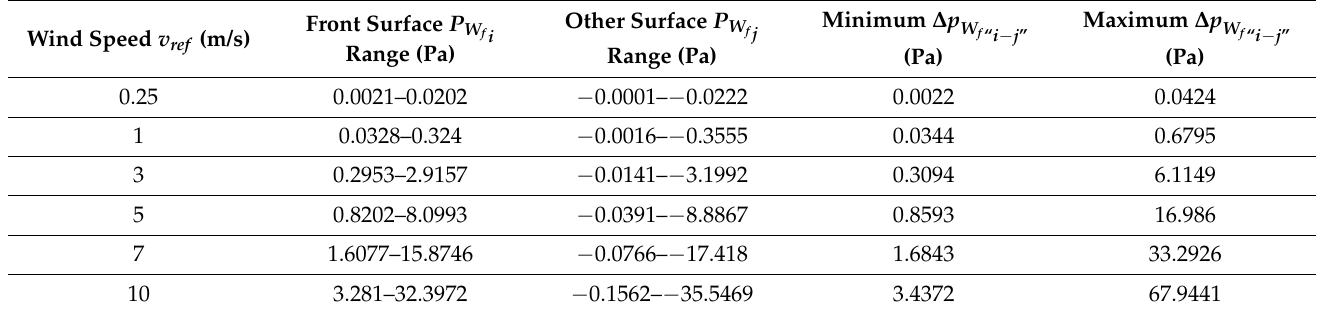
= P − P W f i W f j for urban/suburban rubble f “ i − j ”